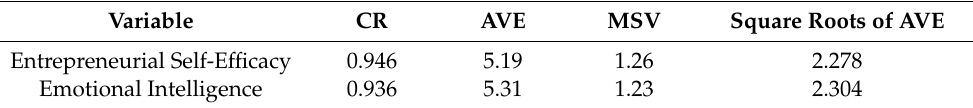
Table 6. Composite reliability, maximum shared variance, average variance extraction, and square roots of AVE.